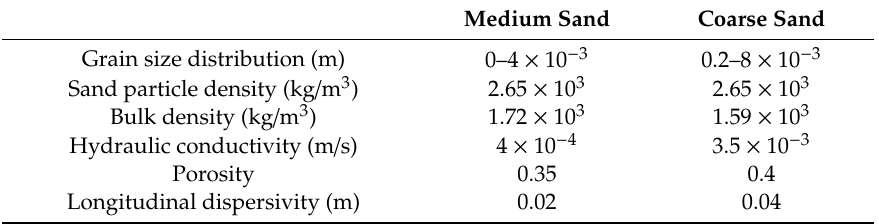
Table 1. Characteristics of the heterogeneous aquifer (medium and coarse